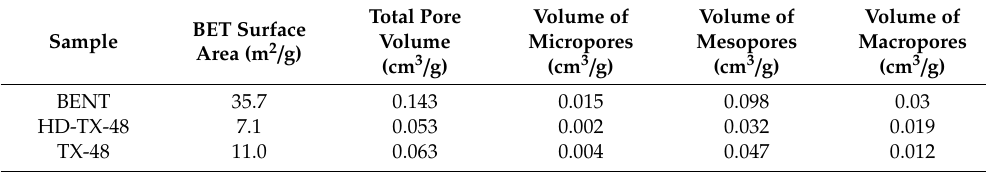
Table 2. The textural parameters of BENT, HD-TX-48, and TX-48.